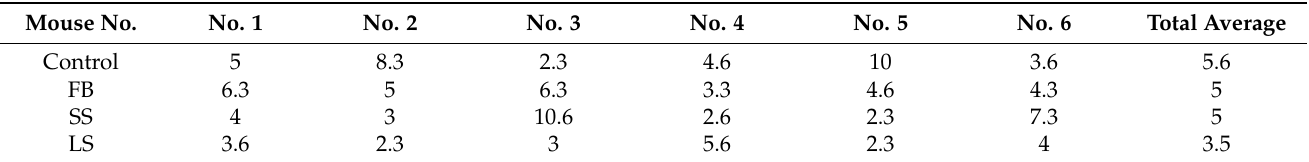
Figure 4. Masson trichrome staining: ( a ) control group; ( b ) FB group; ( c ) SS group; ( d ) LS group. FB, fibroblasts; SS, short-term sphere-forming culture; LS, long-term sphere culture (scale bar 100 µm). Collagenized tissue is stained in blue while other tissues are stained red.